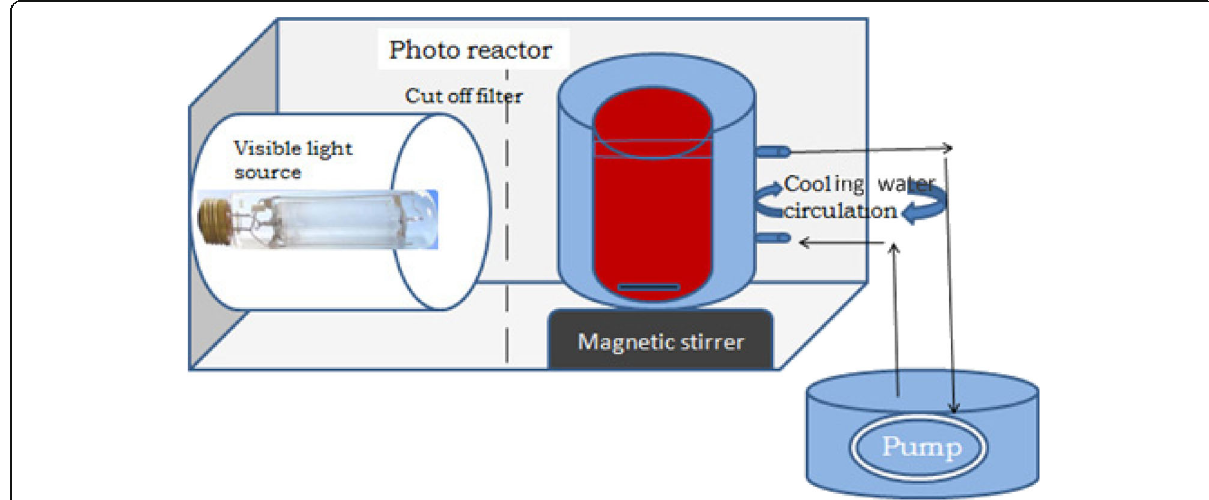
shown in Fig. 2. All samples including undoped TiO calcined at 450 °C for 5 h showed the formation of ana- tase phase having characteristic high-intensity diffraction peak at 2 θ = 25.3° along with other corresponding small diffraction peaks at 2 θ values 37.9, 48.1 and 54.1° that can be indexed to planes of (101), (004), (200) and (211) of anatase phase respectively (JCPDS No. 21 – 1272). No extra peak found at 2 θ = 27.8°, indicating that there is no formation of the rutile phase. As the ionic radii of Mn 2+